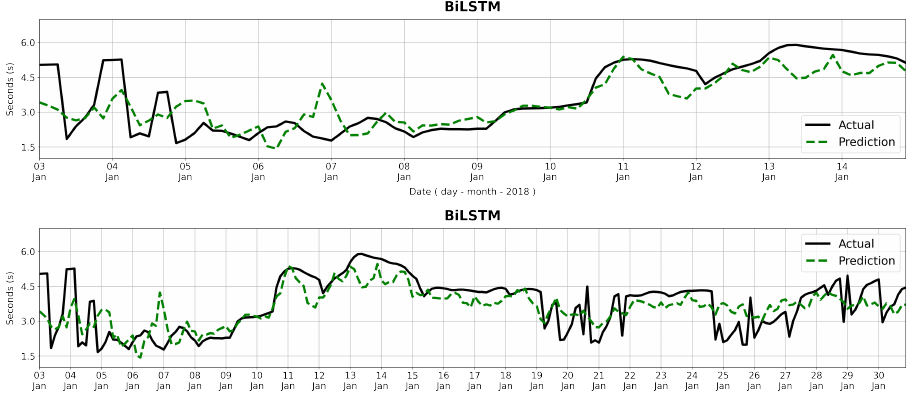
Figure 18. Results of peak wave period (Tp) prediction for 14 (upper plot) and 30 days (lower plot) ahead using the BiLSTM model with 15 years of training data.